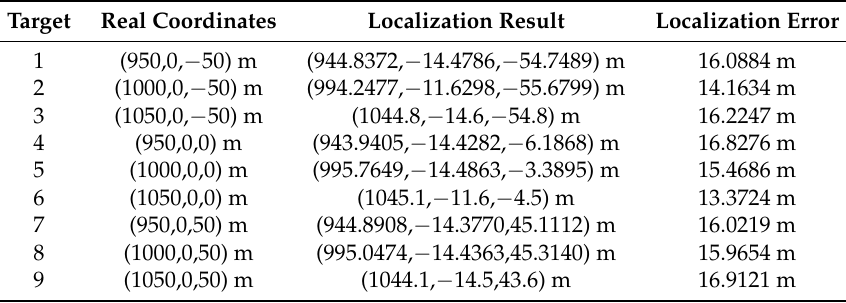
Table 5. Platforms’ position with large error simulation